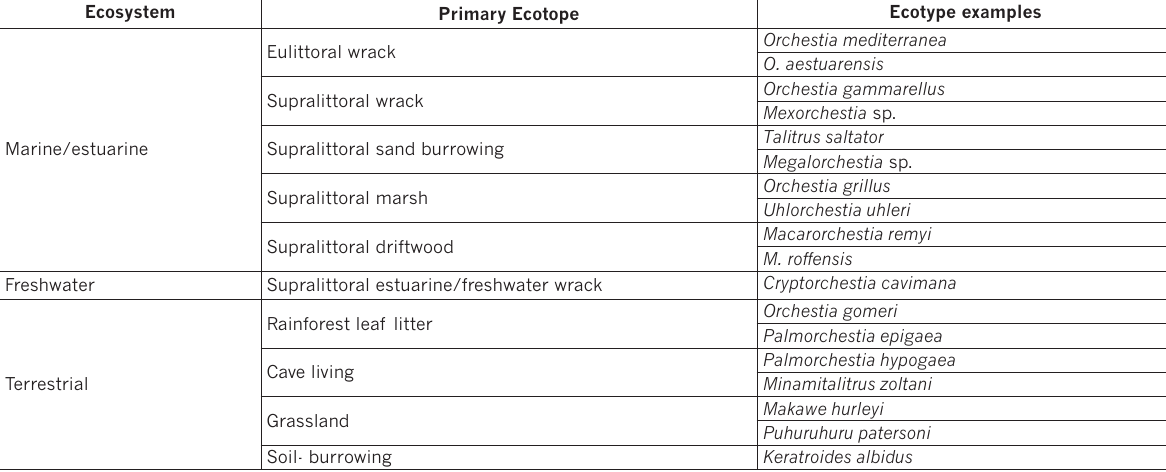
Table 1. Classification of primary Talitrid ecotopes, with some examples of the ecotypes occupying them.